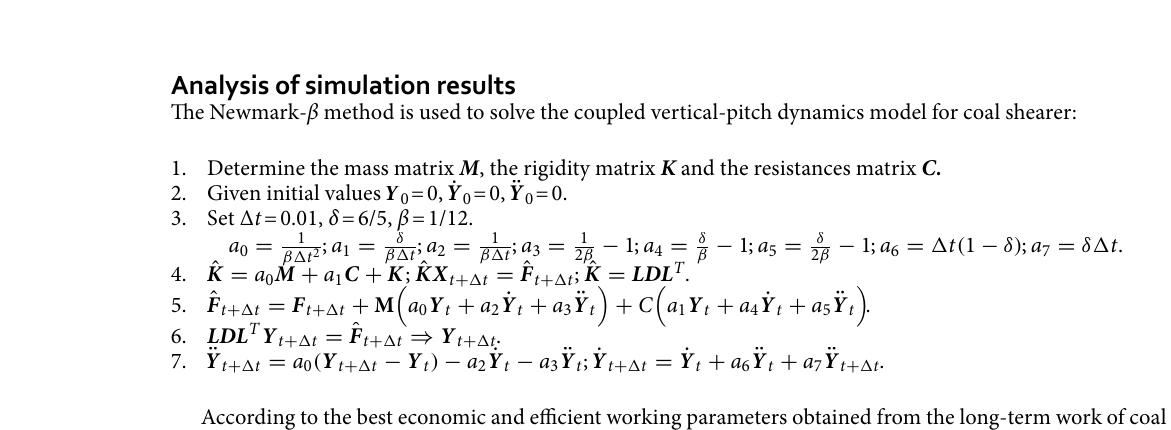
Table 4. Comparison verification (average